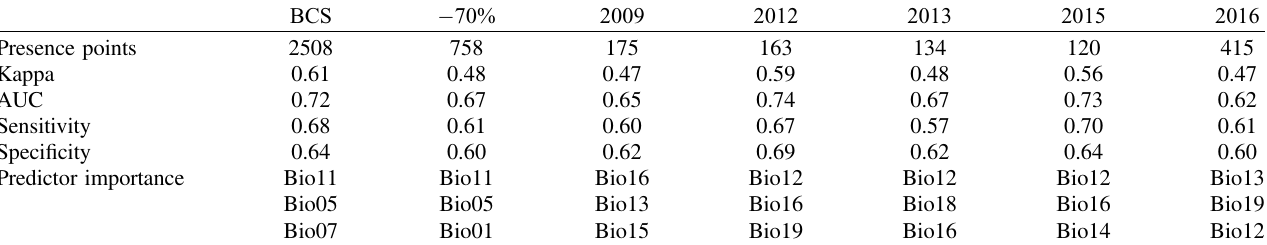
Table 3. Statistical model output using RF of Dicrocoelium dendriticum : BCS and (cid:1) 70% of baseline model compared to statistical output